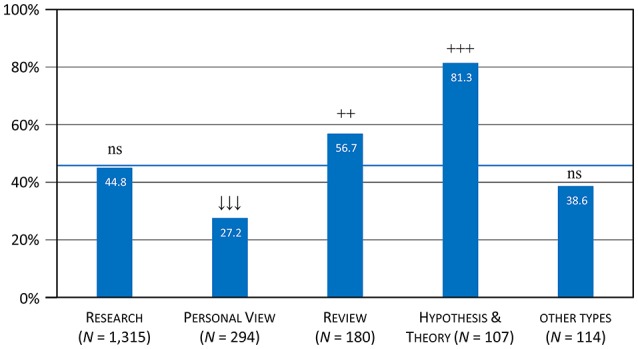
Proportion of article types with theory-related terms (Table 4B, all six terms). The blue line represents the average proportion of 44.9% based on the total of 2,046 articles.